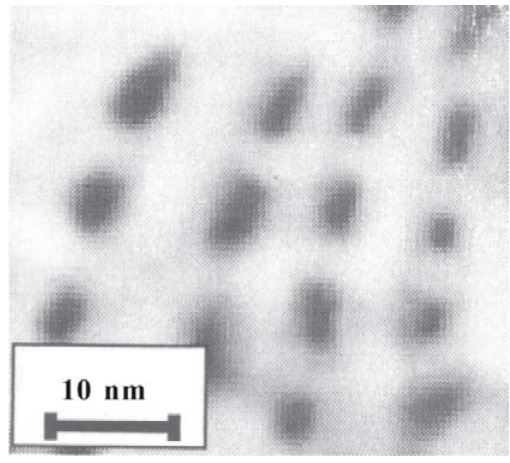
Fig. 12. The chains of equidistant nanocrystals, formed in severe plastic deformation of the Fe-Ni-B amorphous alloy. Transmission electron microscopy.